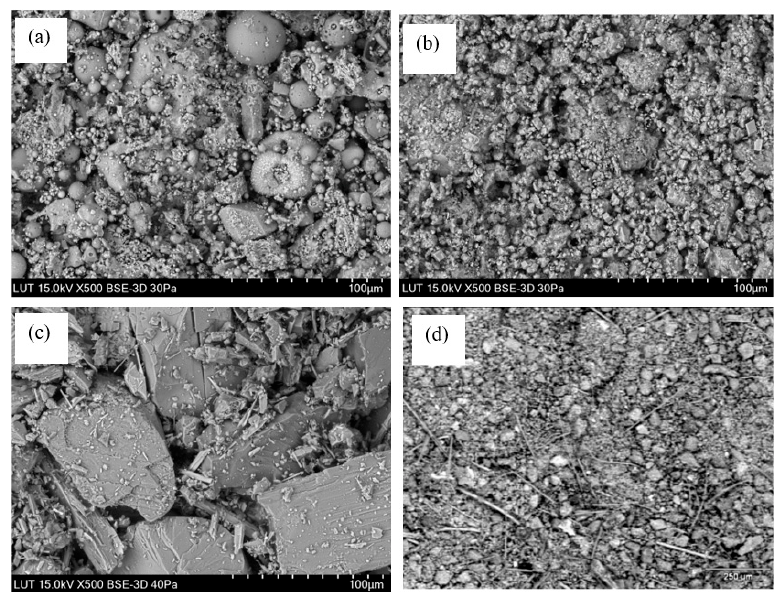
Figure 2. Scanning electron microscope images of industrial materials used in this study: ( a ) ash from bark furnace; ( b ) green liquor slag; ( c ) flotation sand; ( d ) CDW. Table 1. Compositions of the construction waste.